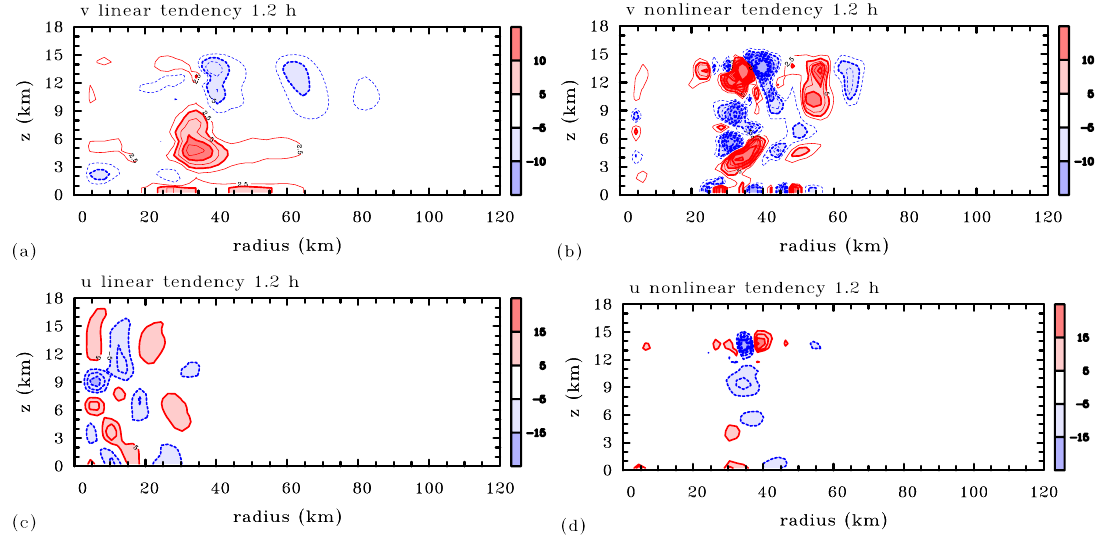
Figure 5. Linear and nonlinear tendency terms diagnosed from the 3DVPAS model at t = 1.2 h integration time. The nonlinear tendency terms are evaluated using the linear solutions. Shown in a radius-height coordinate system are ( a ) sum of linear terms from the disturbance tangential velocity equation; ( b ) sum of nonlinear terms in the disturbance tangential velocity equation (Equation (8)) evaluated using the linear solutions; ( c ) sum of linear terms in disturbance radial velocity equation; ( d ) sum of nonlinear terms in disturbance radial velocity equation (Equation (7)) computed using linear solutions. Contour interval for all panels is 2 m s − 1 h − 1 ; solid positive and dashed